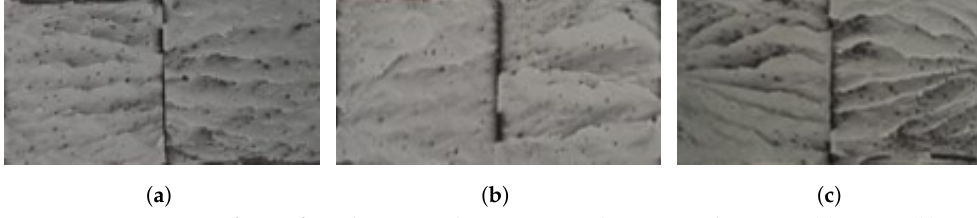
Figure 22. Fracture surfaces of aged joints with PBT-GF30 substrates with 0.5 mm ( a ), 1 mm ( b ), and 2 mm ( c ) of adhesive thickness.